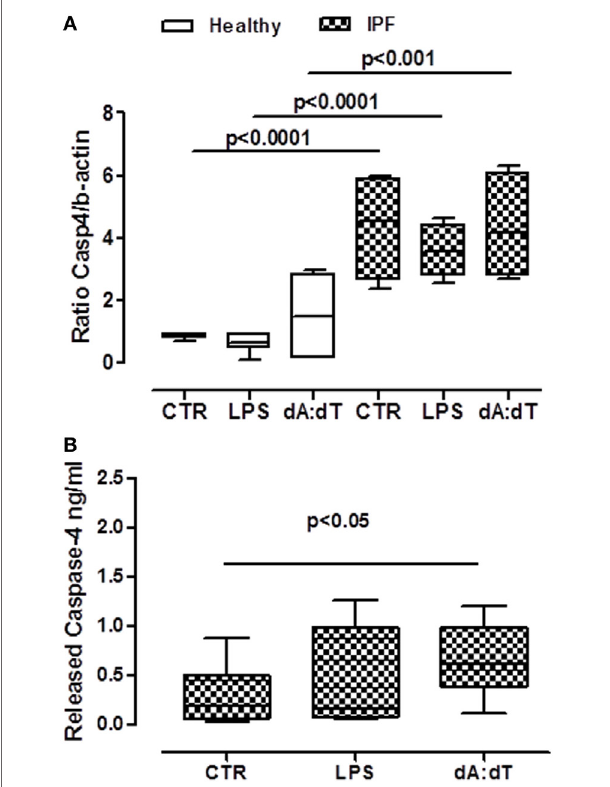
FigUre 6 | Caspase-4 extracellular release from idiopathic pulmonary fibrosis (IPF) peripheral blood mononuclear cells (PBMCs) after AIM2 inflammasome activation. (a) PBMCs derived from IPF patients showed higher basal levels of caspase-4 mRNA compared with healthy subjects. (B) Caspase-4 release in the supernatant of IPF-derived PBMCs increased after 5 h of treatment with LPS and dA:dT. Data are represented as median ± interquartile range ( n = 13). Statistically significant differences were determined by one-way ANOVA followed by Bonferroni’s multiple comparison post-test.